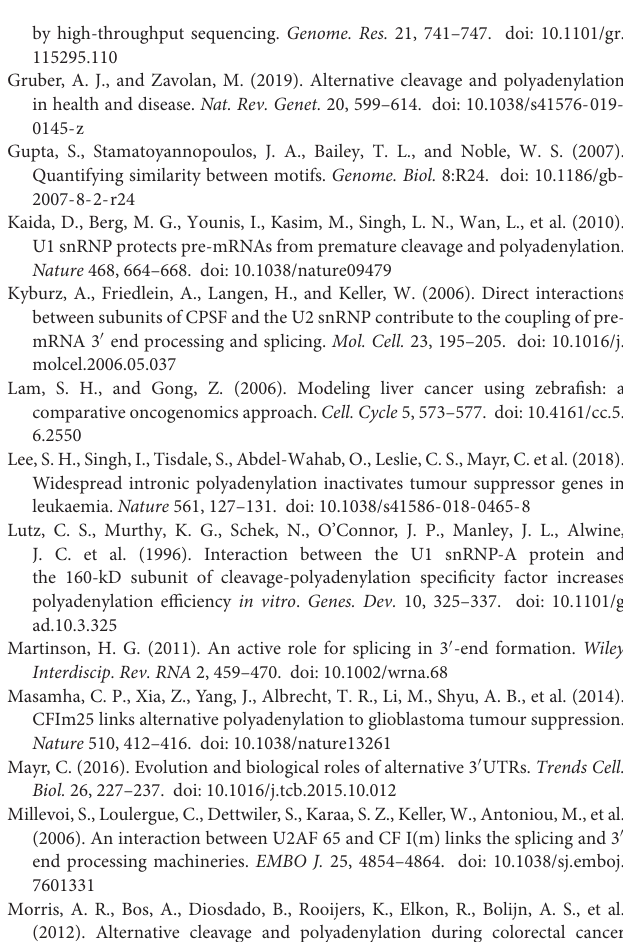
Supplementary Figure 4 | GO enrichment. Barplots showing the enriched GO biological processes identified by the gene set analysis using DAVID in up- (upper) or downregulated transcripts (lower). Supplementary Figure 5 | TCGA APA analysis. TCGA APA events were grouped based on CPSF1 median mRNA expression score (high vs. low) to compare the APA between patient groups. Four representative genes showed statistically significant differences including RNF14, FAM177A1, MED29, and TUBA1A. Statistical analysis was performed using Student’s t -test. Supplementary Figure 6 | Motif analysis and interacting RBPs identified in 3 (cid:48) UTRs regulated by CPSF1. (A) Lengthened and shortened sequences of 3 (cid:48) UTR transcripts regulated by CPSF1 were analyzed using the MEME motif discovery tool, and the significance threshold was set at E-value < 0.05. The motifs were submitted to the Tomtom motif comparison tool for RBP identification. The top three significant RBPs identified are shown. (B) Lengthened and shortened sequences of 3 (cid:48) UTR transcripts regulated by CPSF1 were analyzed by TargetScan tool. The APA event number and microRNA target sites are indicated. Supplementary Figure 7 | CMPK1 was regulated by CPSF1. CPSF1 was knocked down or overexpressed in HepG2.2.15 and HCCLM3 cells. The mRNA level of CMPK1 (A) PDUI and (B) PSI was determined by qRT-PCR. Statistical significance was calculated by one-sample Student’s t -test. (C) Cell proliferation was detected using the CCK8 assay over five consecutive days. The relative absorbance was measured at OD 450 . Statistical data are presented as mean ± SD. * P < 0.05 and ** P <